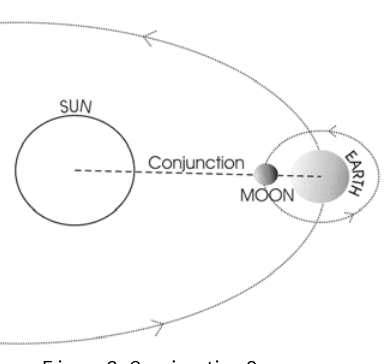
Figure 2. Conjunction